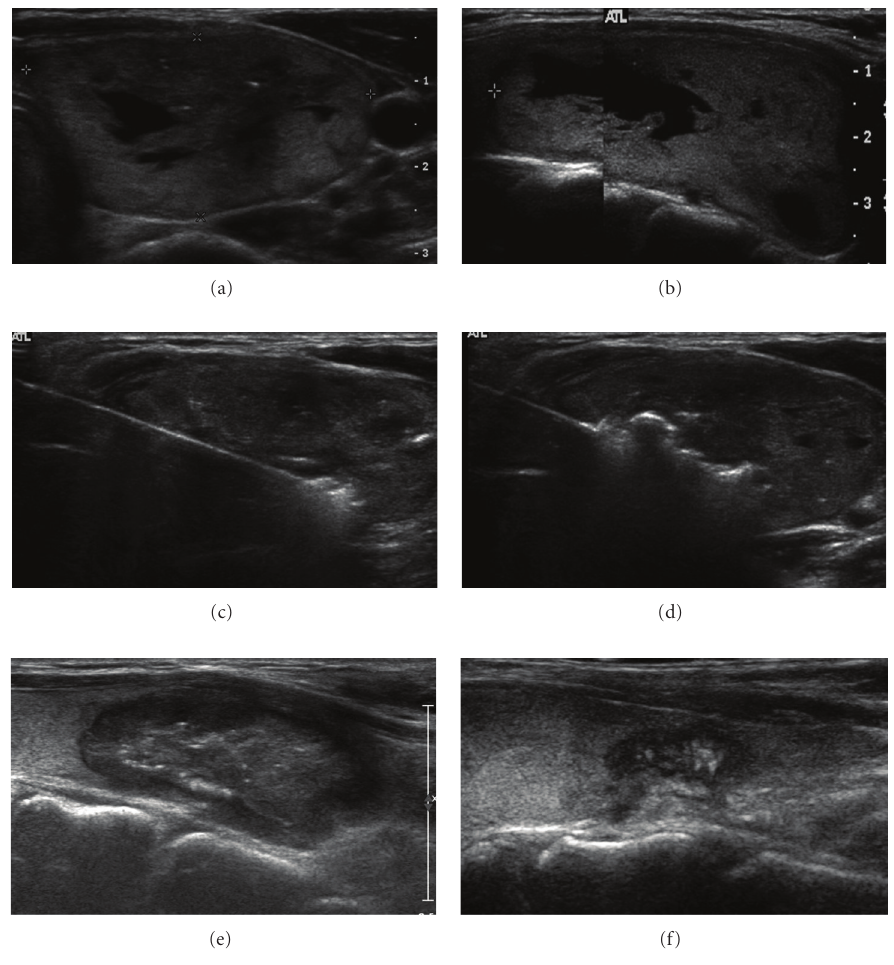
Figure 2: Sequential US images of benign thyroid nodules. (a), (b). Transverse (a) and longitudinal (b) US images show a predominantly solid nodule in the right lobe. The volume before treatment was 35mL. (c). A transverse US image shows ablation of the periphery of a deep and remote portion of the nodule. The needle was inserted through the isthmus. (d). The transverse US image shows relocation of the electrode tip in the more central, untreated area. The second and third sessions of the RF ablation were performed within a one-year interval (not shown). (e), (f). Transverse US images one (e) and three-and-half (f) years following the initial RF ablation show progressive volume reduction. The final volume was